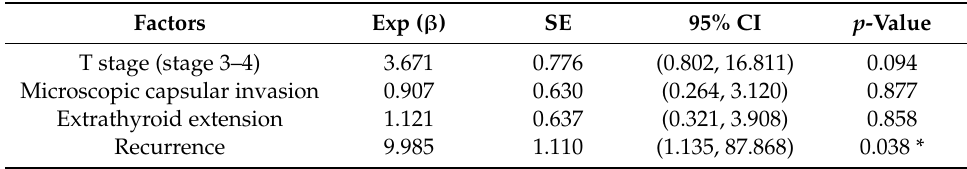
Multivariable analysis of the relationships between FGF21 serum levels and clinicopathological